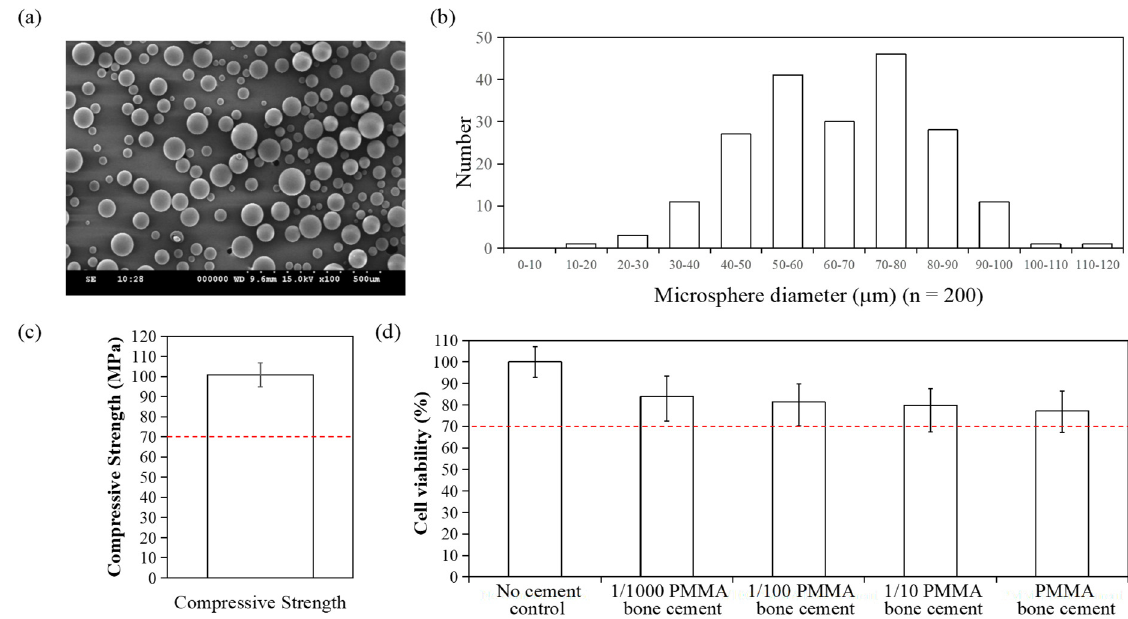
Figure 2. Characterization of PMMA bone cement. ( a ) SEM image of PMMA bone cement. ( b ) Particle diameter distribution of PMMA. ( c ) Compressive strength of PMMA bone cement. ( d ) Cell viability of L929 cells measured by MTT assay for evaluating the biocompatibility of PMMA bone cement. The dashed lines indicate the ISO standard for compressive strength (70 MPa) and cell viability (70%).